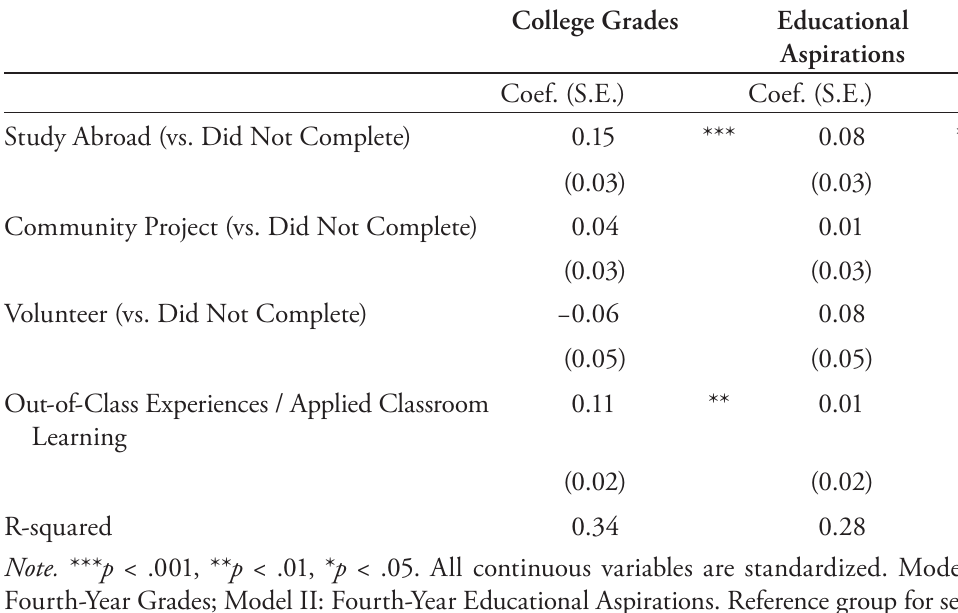
Table 3. Regression Estimates for the Association Between Applied Learning and Students’ Fourth- Year Grades and Fourth- Year Educational Aspirations (n = 4,028) ( continued